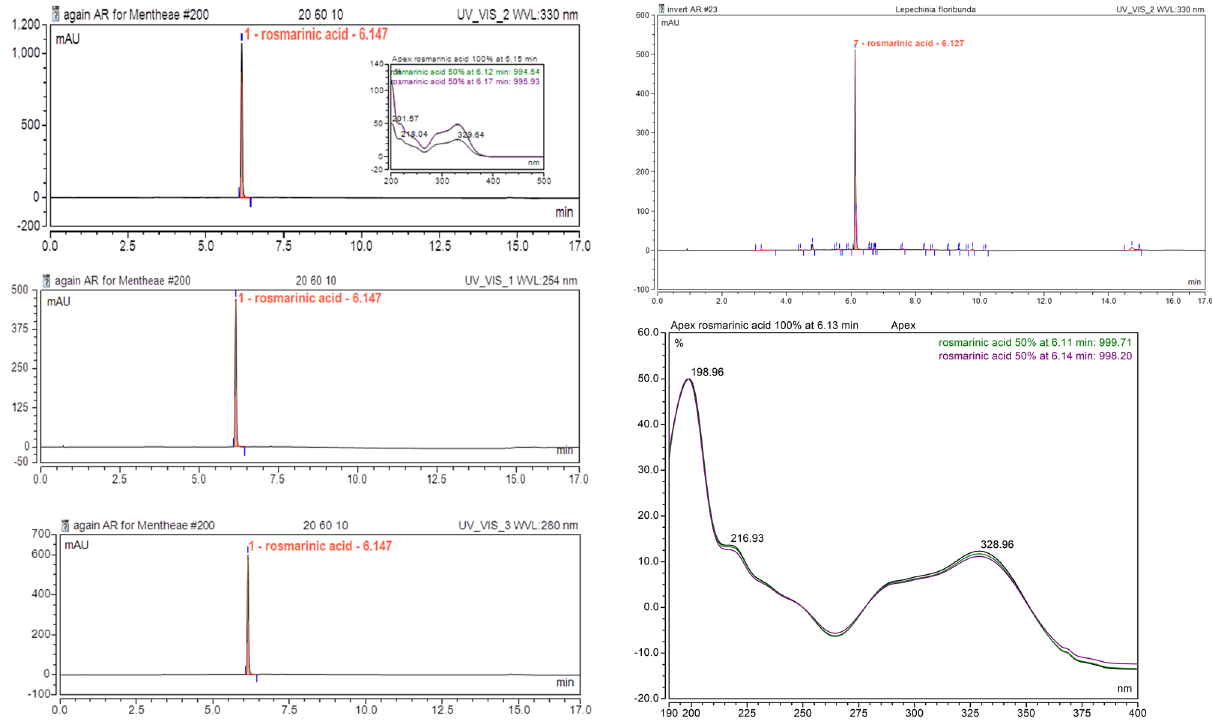
Figure 5. Chromatographic purity of rosmarinic acid at three different